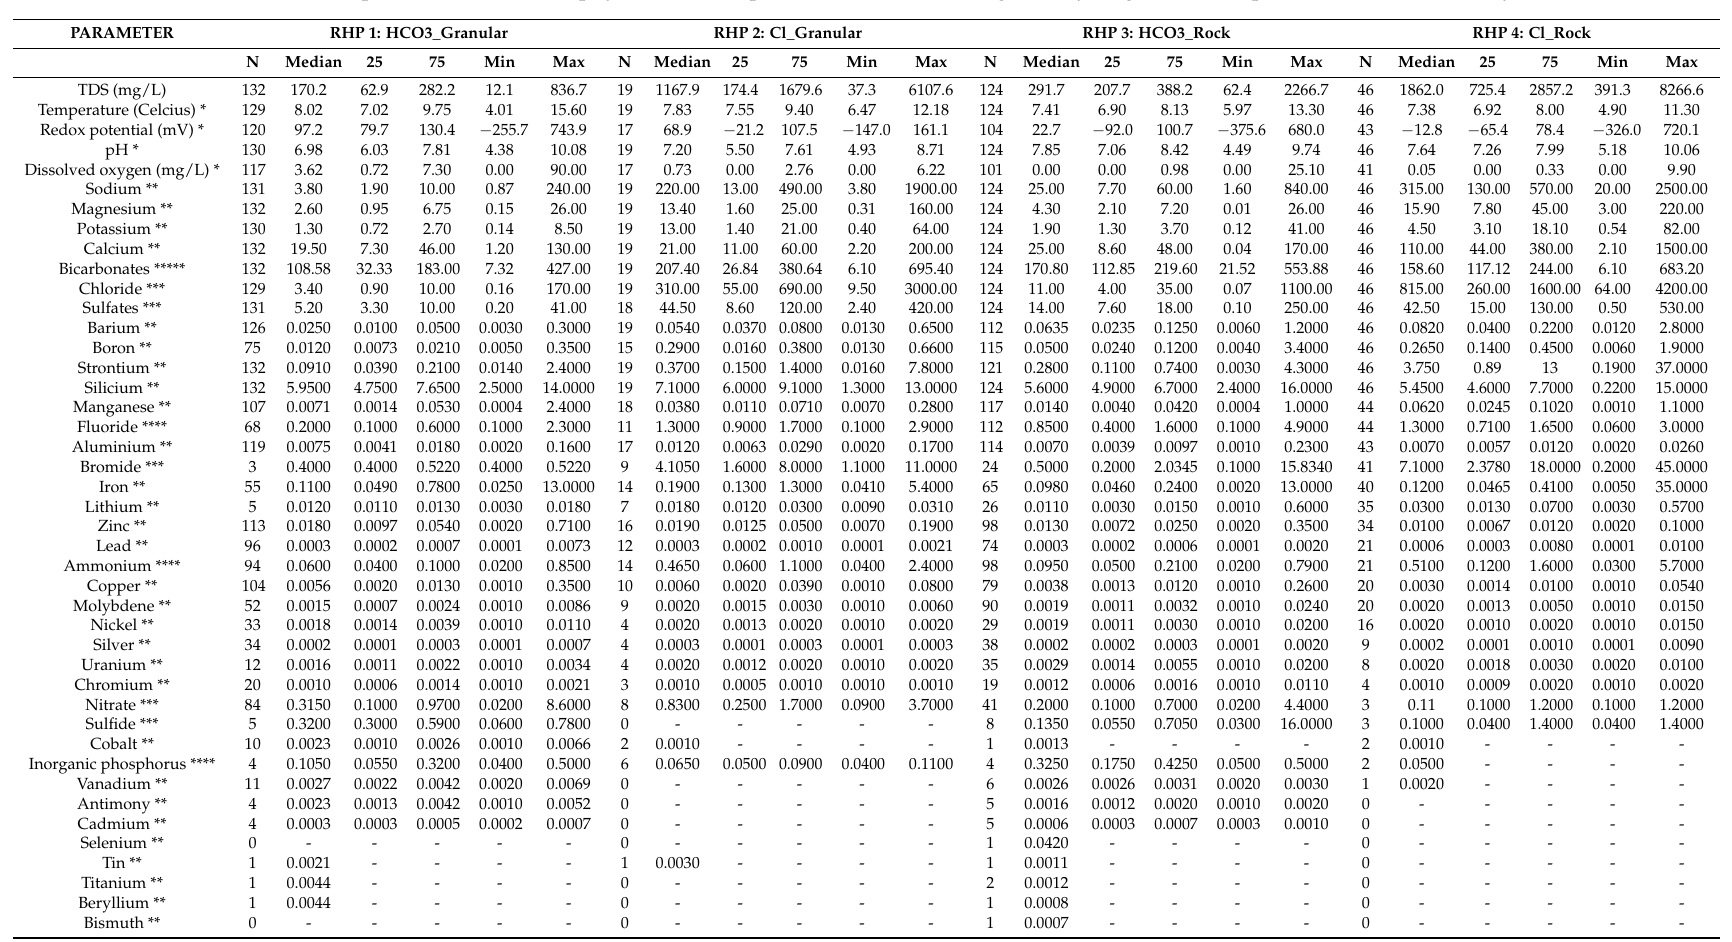
Table 1. Descriptive statistics for the physicochemical parameters of the four regional hydrogeochemical poles defined in this